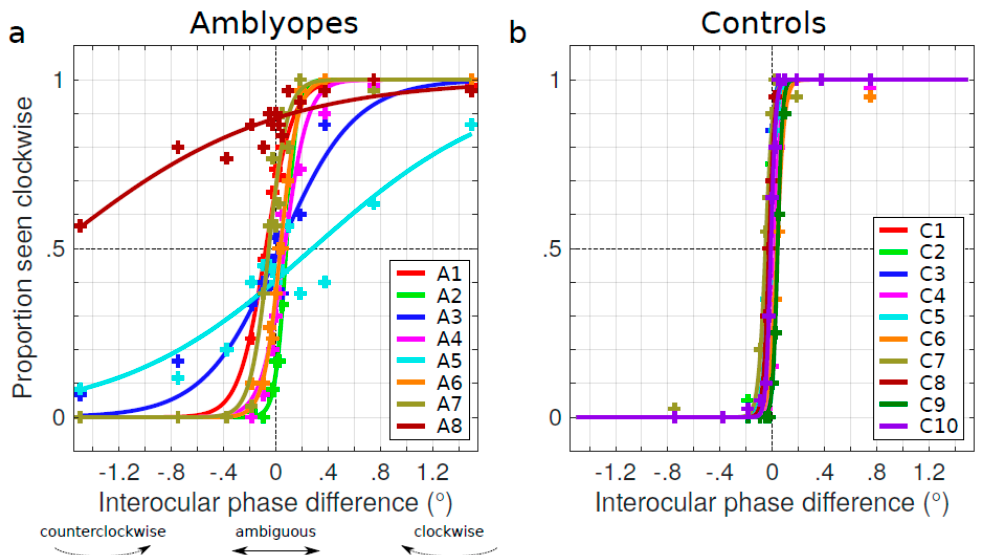
Figure 2. ( a ) Psychometric functions of the perceived direction as a function of the interocular phase difference for all eight amblyopic subjects. The midpoint of the logistic function at 0.5 performance defines the point of subjective equality (PSE). ( b ) Psychometric functions of the perceived direction as a function of the interocular phase difference for the control subjects from our previous article [24].